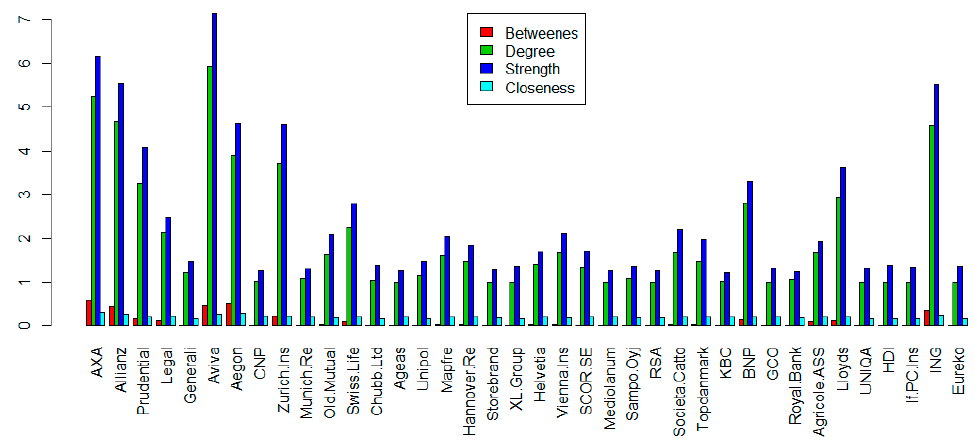
Figure 5. Average betweenness centrality, vertex degree, vertex strength, and closeness centrality. Source: Own study.